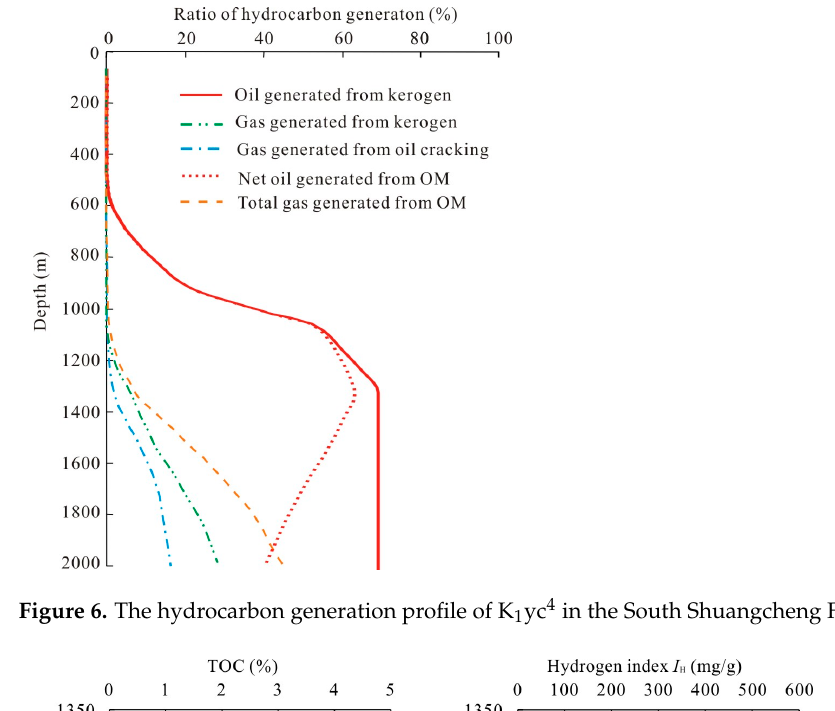
Figure 5. The sedimentary and burial history and thermal history of K 1 yc 4 in the South Shuang- cheng Fault Depression.